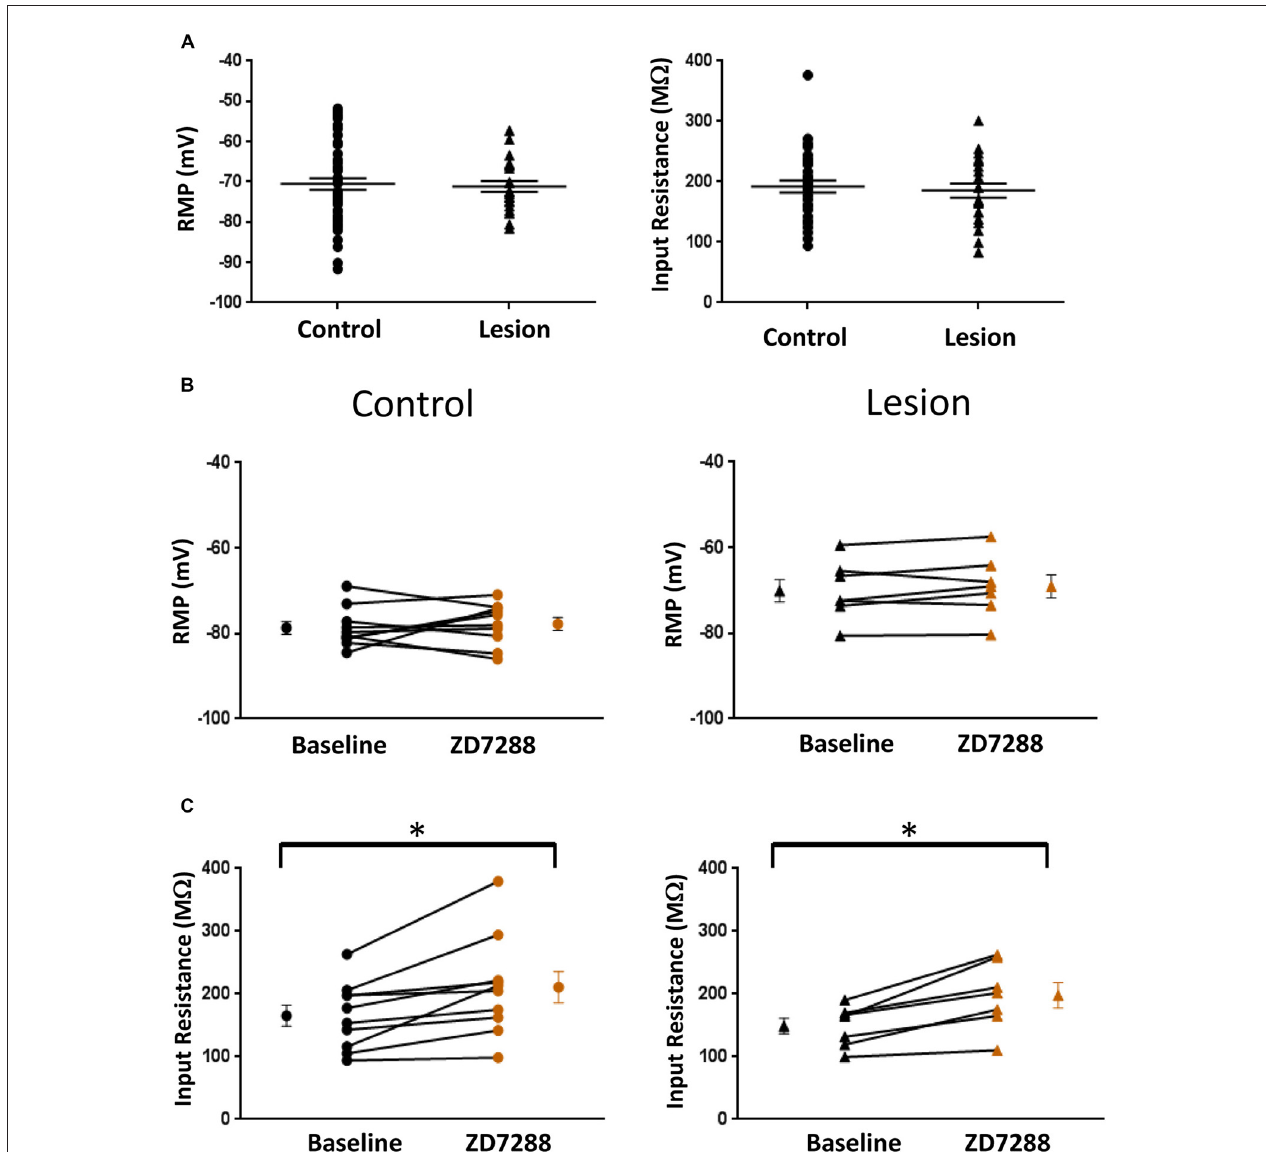
FIGURE 2 | Comparison of fast-spiking interneuron intrinsic properties in control and freeze lesion groups. (A) Histogram of RMP (left) and input resistance (right) results from fast spiking interneurons in control and lesioned animals. Membrane potentials (Control: n = 50, Lesion: n = 22) and input resistances (Control: n = 35, Lesion: n = 22) were not significantly different. (B) Application of ZD7288 to inhibit HCN channels did not significantly alter the RMP of cells from control (left; n = 10) or lesioned (right; n = 7) animals. (C) The input resistance of cells from both control (left; n = 10) and lesioned (right; n = 7) animals increased following ZD7288 application. ∗ p < 0.05, paired t -test. Error bars are mean ± SEM.